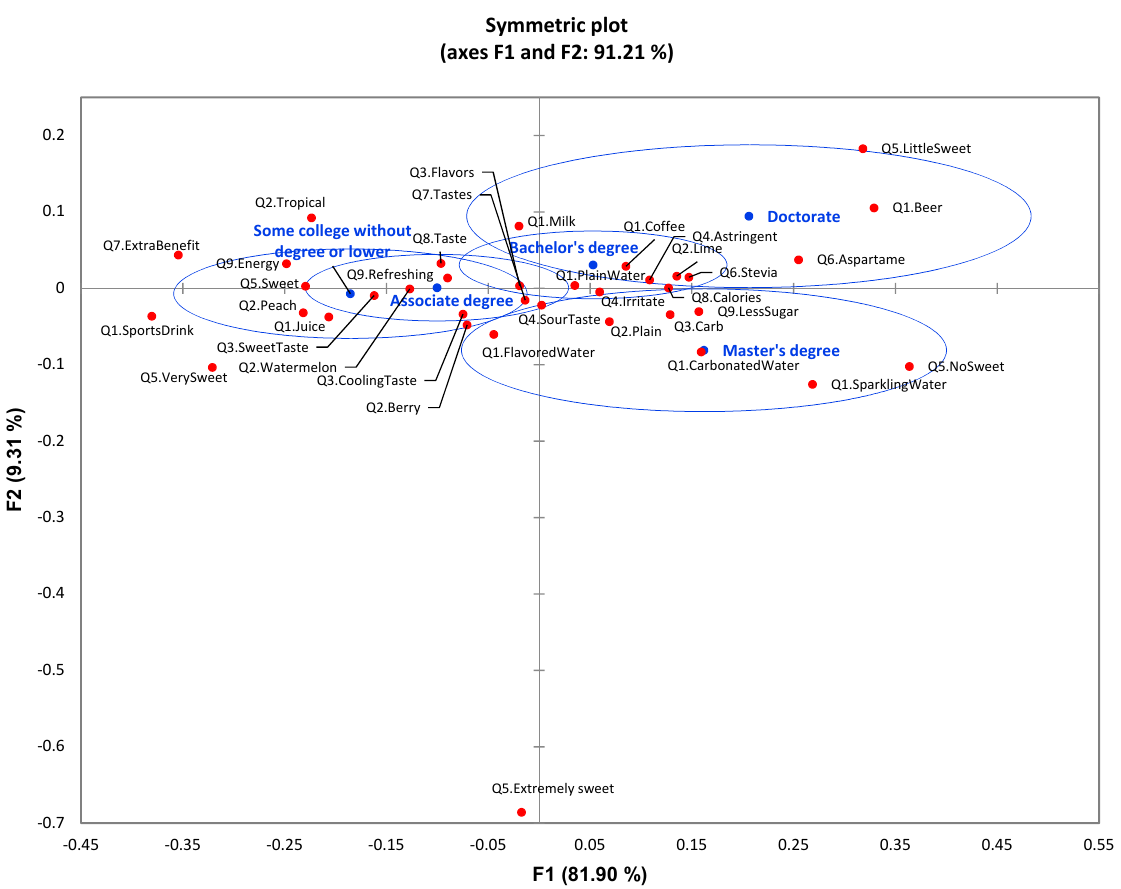
Figure 13. The first two dimensions of correspondence analysis (CA) symmetric plot using education level (some college without degree or lower, associate degree, bachelor’s degree, master’s degree, and doctorate) as Rows and all nine survey questions as Columns ( n = 901) (5 rows × 44 columns). Confidence ellipses on the plot were automatically created by XLSTAT software based on CA with observed χ 2 = 375.26 and p < 0.0001.